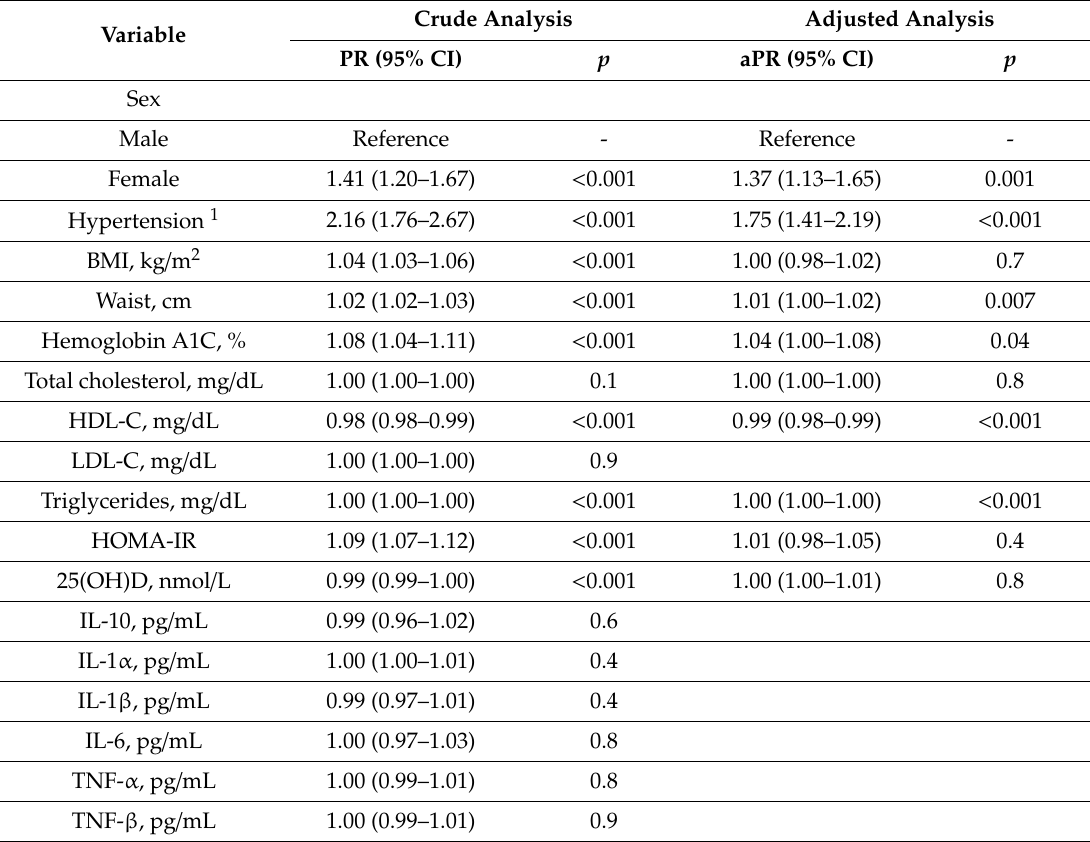
Table 4. Crude and multivariate adjusted Poisson regression for modeling the number of metabolic syndrome parameters (n =